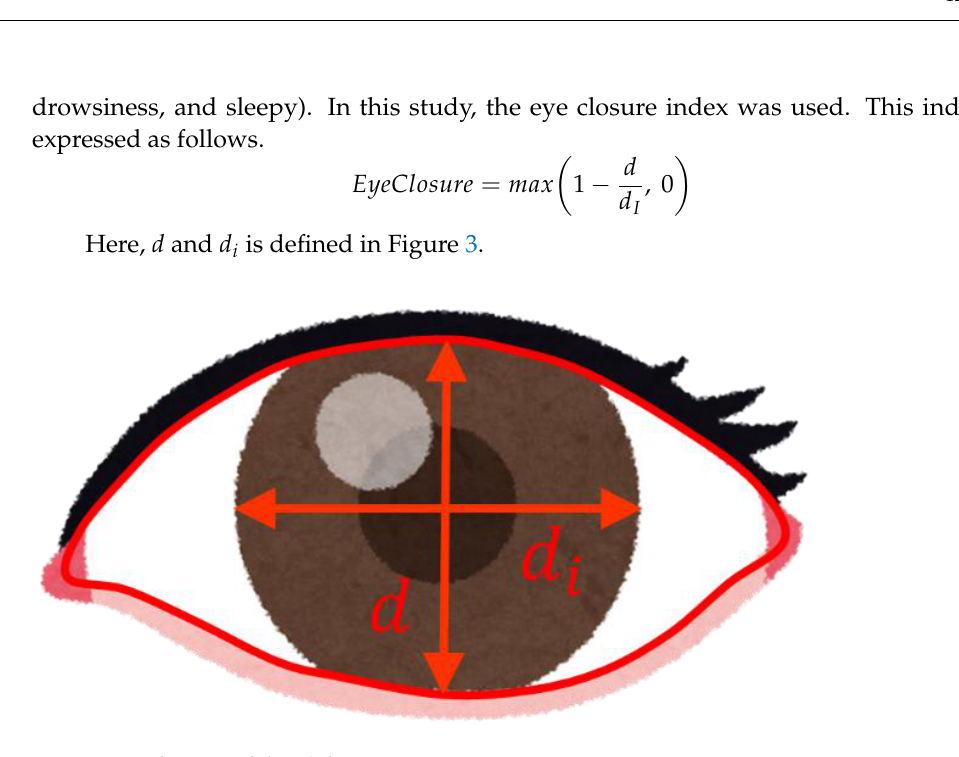
Figure 3. Definition of d and d i Logistic regression was used with eye closure and head movement, KSS, the inci- dence of the HFC and lane departure, and lateral standard deviation as explanatory vari- ables. Fatima et al. used TensorFlow, Python3, and OpenCV to detect sleepiness in real- time [73]. They used yawning, prolonged eye closure, reduced driver movement, lane change, and oversteering for training. If these data indicate that the driver is not paying attention, the alarm sounds in the car, and the driver ’ s seat begins to vibrate. If the driver does not respond, the system takes measures such as gradually slowing down the car.